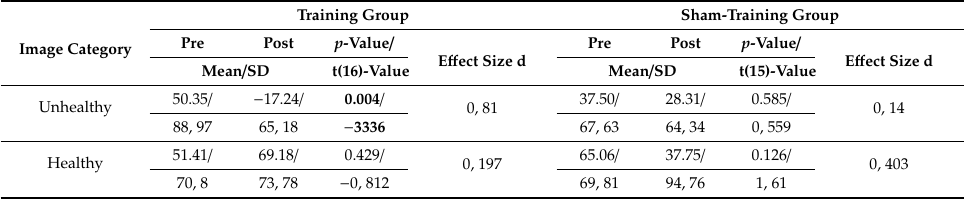
Table 2. Bias scores for healthy and unhealthy images in the training and sham-training group for the pre- and post-phases. p -values reflect significance of changes from pre to post in bias